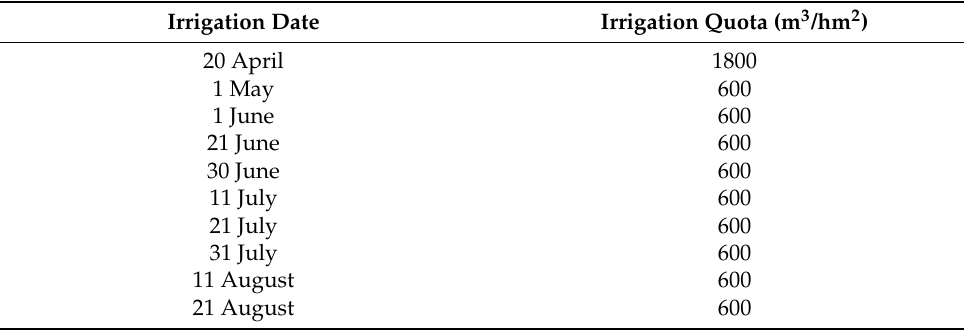
Table 2. Monthly groundwater levels for the irrigation season in the year 2013 – 2014.